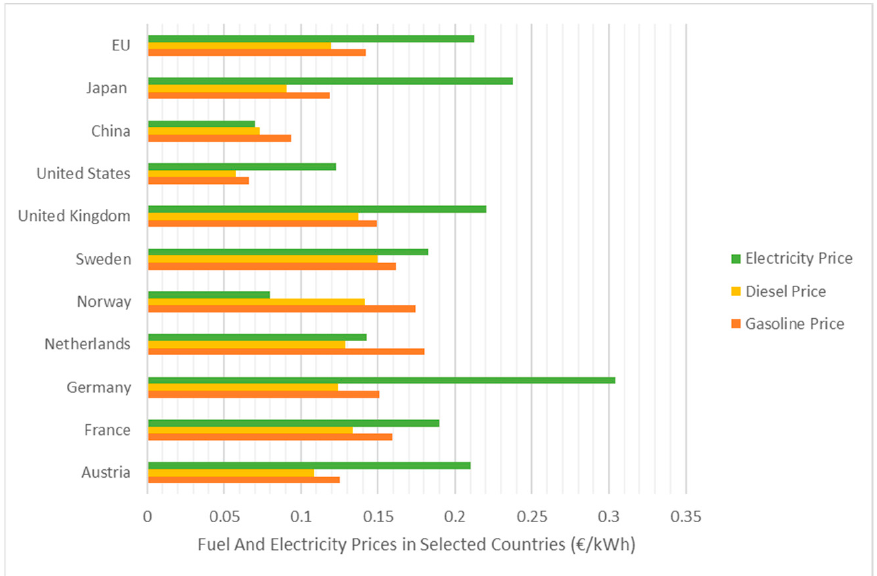
Figure 7. Fuel and electricity prices in €/kWh in the USA, China and selected European countries in 2020 [39,40].